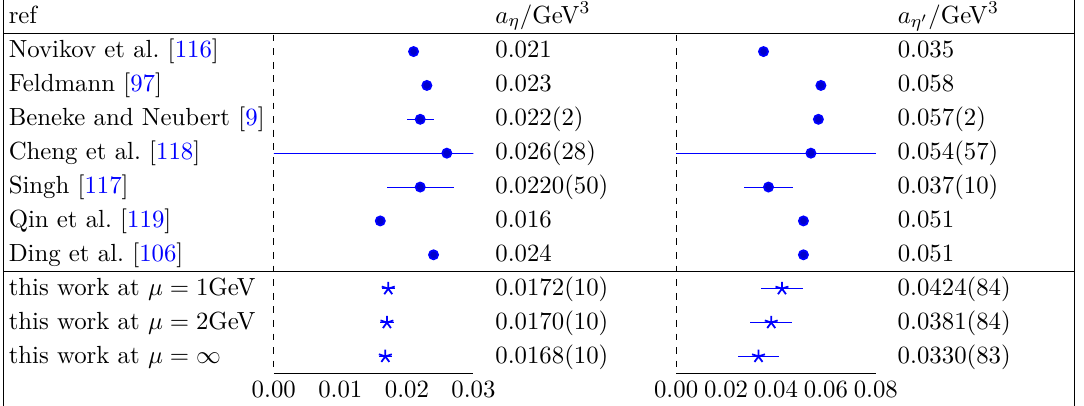
Table 20. Literature values for the anomaly matrix elements in comparison with our results at various scales. Note that the error bars of [118] are cut off at both